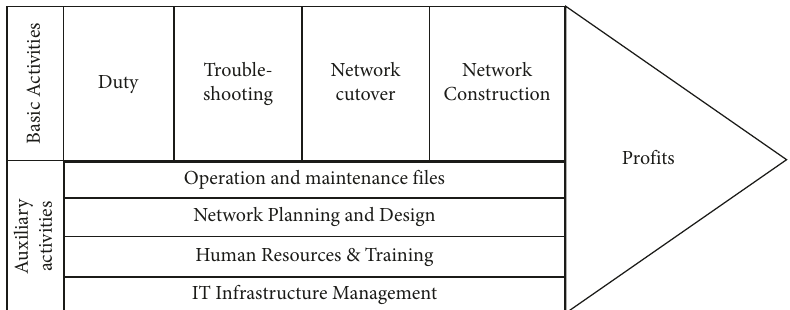
Figure 5: Network operation and maintenance value chain model.